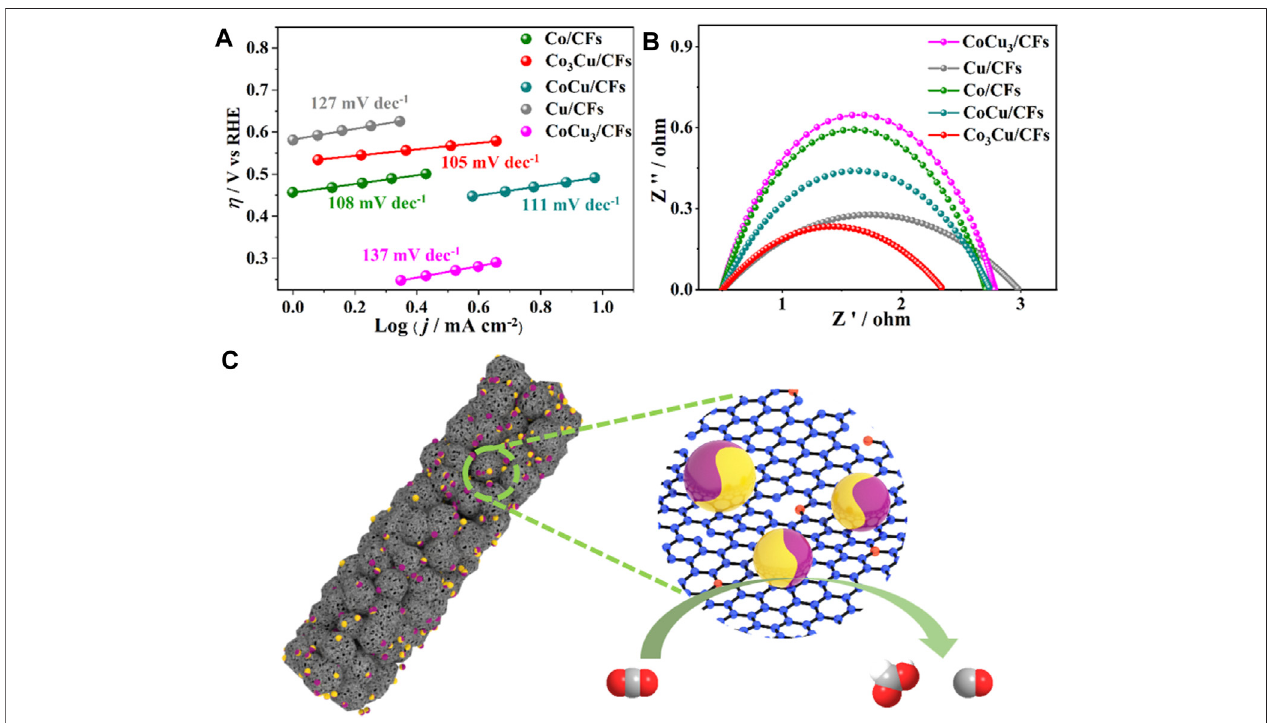
FIGURE5|(A) Tafelplotsof fi vesamplesduringtheCO CFs for the reduction of CO 2 to CO and HCOOH.